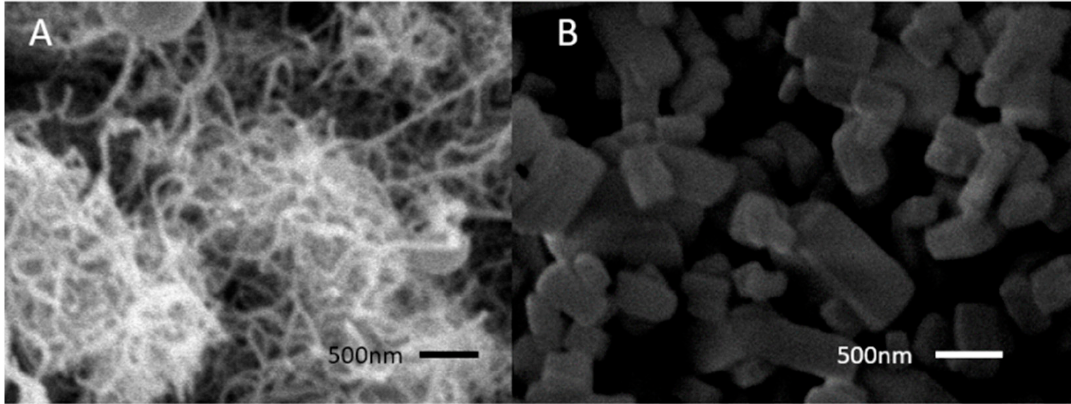
Figure 1. SEM images of ( A ) MWCNTs and ( B )CAU − 1 .